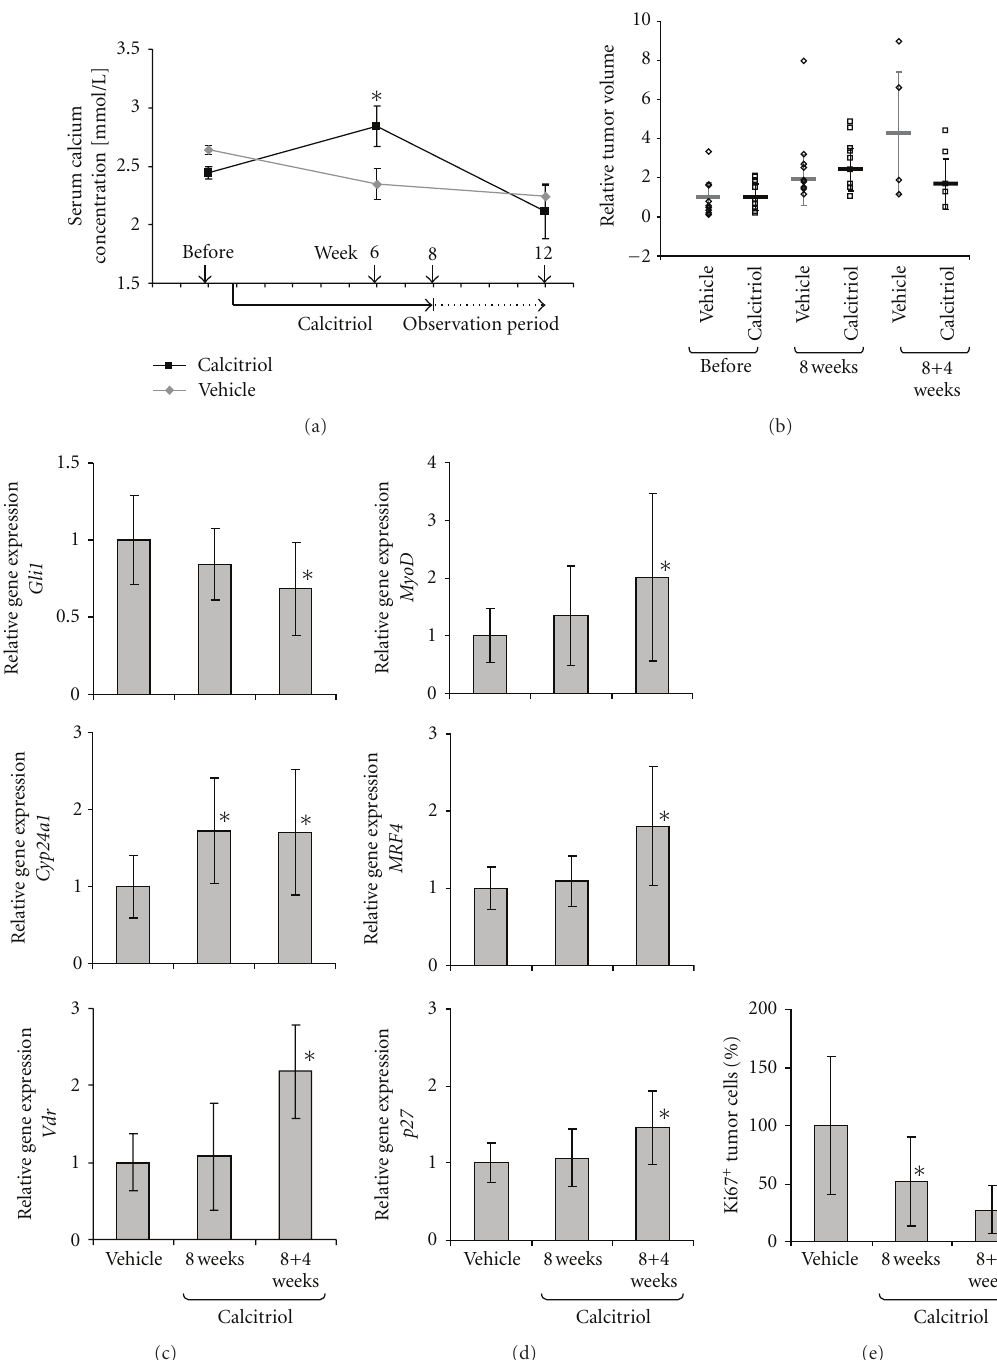
Figure 2: Calcitriol inhibits Hh signaling and proliferation and induces Vdr signaling and di ff erentiation of ERMS in Ptch neo67/+ mice in vivo . (a) Calcitriol treatment scheme and calcium serum concentrations of ERMS-bearing Ptch neo67/+ mice. Animals were either sacrificed directly at therapy end (8 weeks of treatment) or after an additional 4-week observation period (dashed arrow). (b) Tumor volume was determined by VCT analysis before therapy (before), at the end of therapy (8 weeks), and 4 weeks thereafter (8 + 4 weeks). Given is the relative median tumor size (horizontal bars) for each time point, the individual tumor volumes (dots), and the standard deviation of tumor volumina. ERMS treated with calcitriol (black) or vehicle (grey). Median tumor volume before onset of treatment was set as 1. Median of the absolute tumor volumes at time point of randomization was 0.011 cm 3 ± SEM 0.0033. (c) Gli1 , Cyp24a1 , and Vdr , (d) MyoD1 , MRF4 , and p27 expression levels and (e) percentages of Ki67 + tumor cells/all tumor cells of ERMS after calcitriol-treatment for 8 weeks (8 weeks) or after the additional 4-week observation period (8 + 4 weeks) compared to vehicle-treated tumors (vehicle). Expression levels were normalized to the expression of 18S r RNA gene. Values of vehicle-treated controls for Gli1 , Vdr, MyoD1, MRF4 , and p27 expression were set to 1. Values of vehicle-treated controls for Ki67 + tumor cells were set to 100%. Asterisks: P < 0 . 05; error bars: mean ±